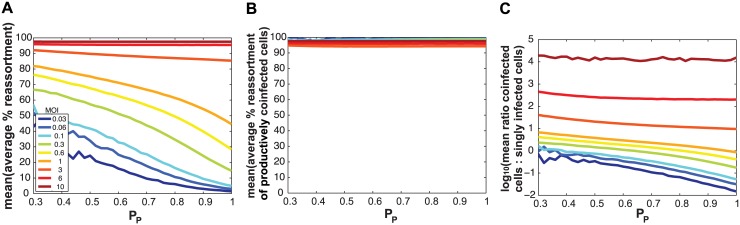
Semi-infectious particles increase reassortment at a given MOI by increasing the proportion of infected cells that are co-infected.Results of computationally simulated co-infections are shown. In each simulation, multiplicity of infection in terms of total particles/ cell was held constant and is indicated by the color scale inset in panel (A). The same PP value, plotted on the x-axis, was assigned to all eight segments and was varied from 0.3 to 1.0 in increments of 0.1. Twenty replicates were run, and the mean of these 20 runs is shown. In (A), the average % reassortment expected under each condition is plotted. Fully infectious progeny viruses generated from all infected cells are considered in this analysis. The results show that, at each MOI, the % of viruses that are reassortant increases with decreasing PP. In (B), the average % reassortment for productively co-infected cells is plotted for each MOI condition. Here, only those fully infectious viruses generated in productively co-infected cells are considered. The results show that, regardless of MOI and PP, the vast majority of fully infectious viruses emerging from co-infected cells have a reassortant genotype. In (C), the ratio of co-infected cells to singly infected cells is plotted on a log 10 scale. This plot shows that, at MOIs less than 3 particles/cell, this ratio increases with decreasing PP. In other words, where PP is lower, a greater proportion of cells are potential vessels for reassortment. A log 10 scale was used to allow visualization of all lines on one graph.